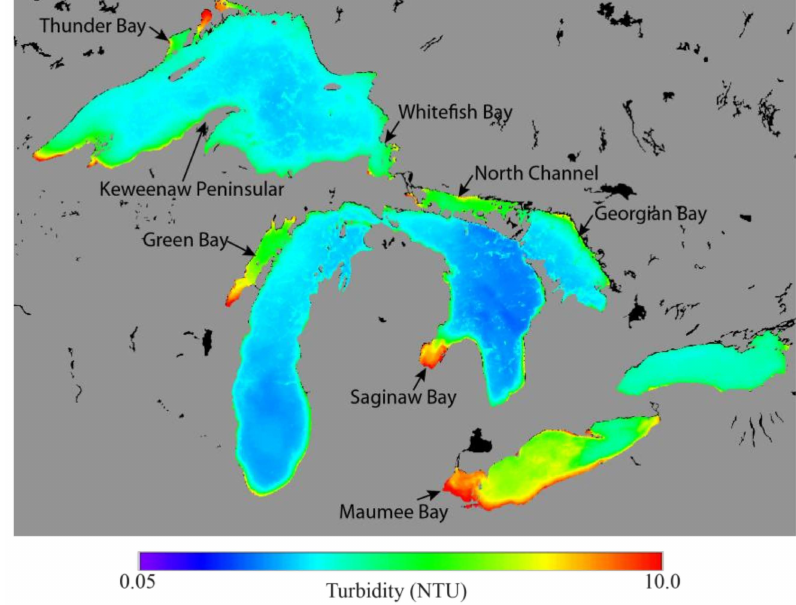
Figure 7. VIIRS–SNPP-measured climatology (2012–2018) water turbidity in the Great